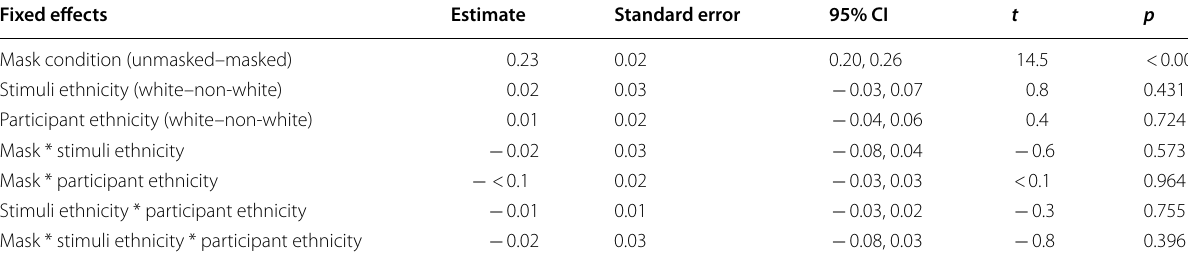
Table 6 Fixed effects table for the white ethnicity linear mixed effects